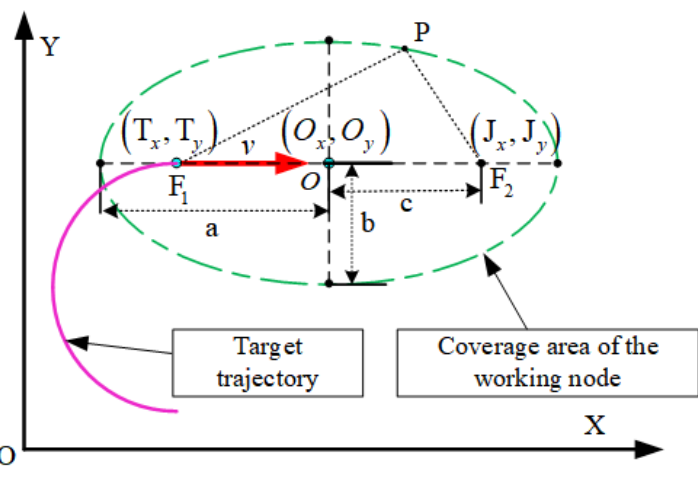
Figure 2. Target motion trajectory and elliptical area.